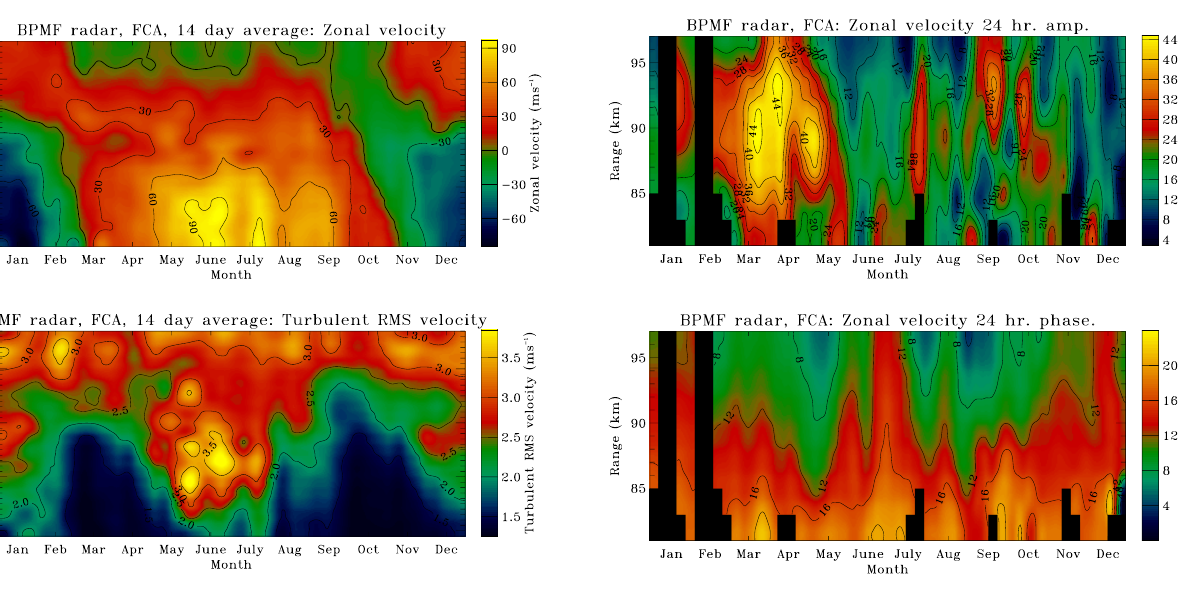
Fig. 4. Zonal velocity diurnal tide amplitude (top) and phase (bot- Figure4.Zonalvelocitydiurnaltide(a)amplitudeand(b)phaseestimatedusing tom) estimated using harmonic harmonicanalysis.